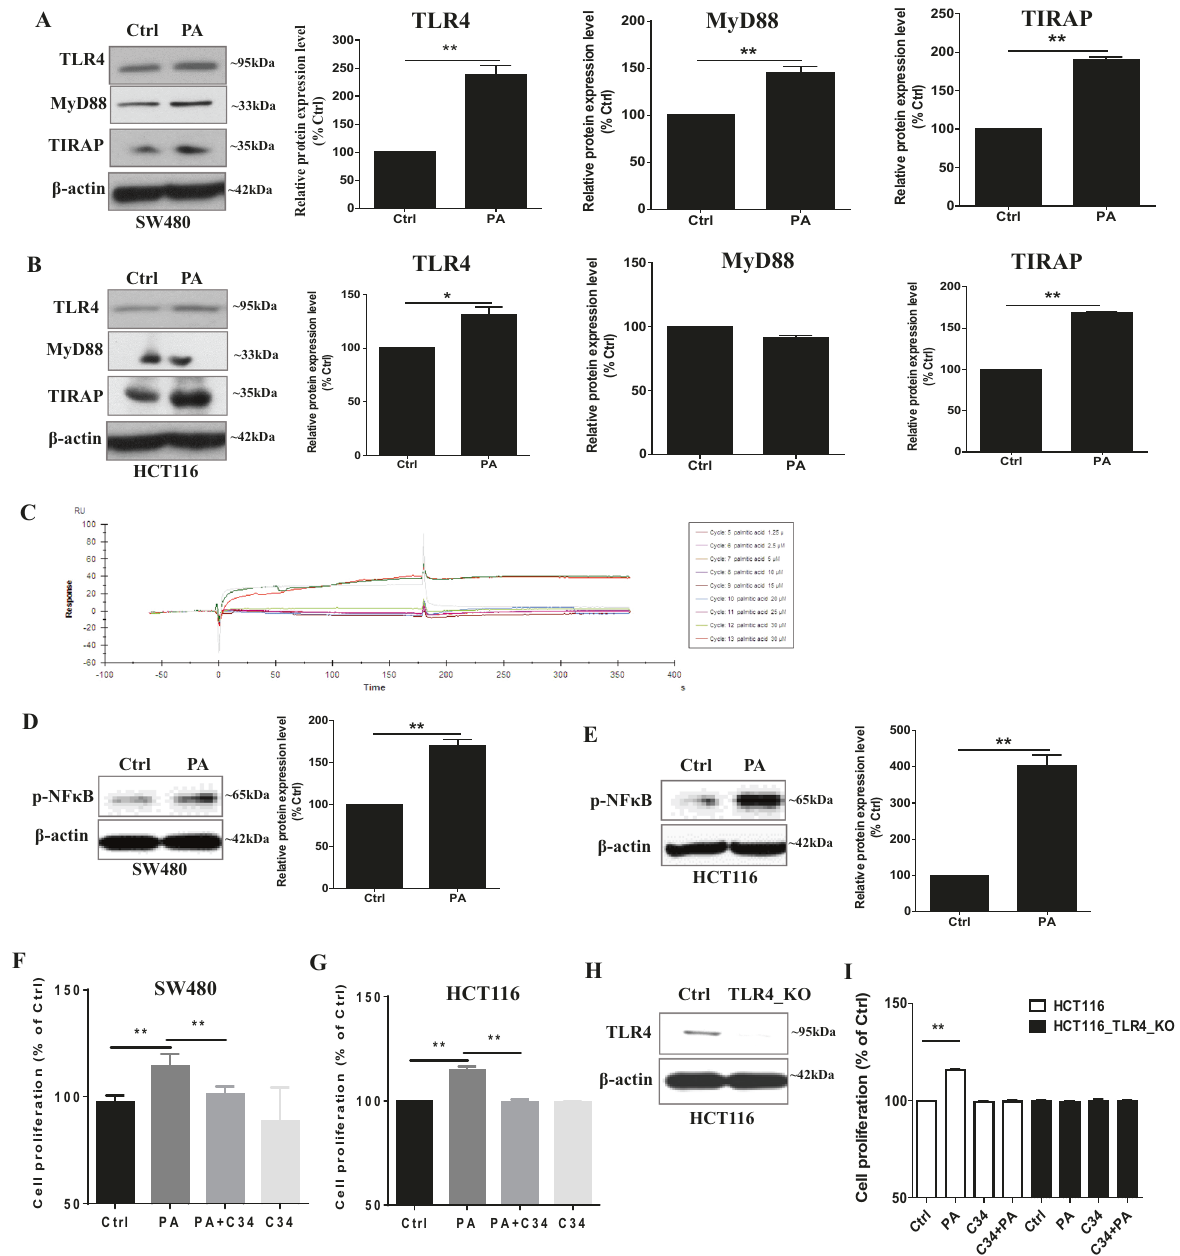
Fig. 4 Palmitic acid increases CRC cell proliferation in a TLR4-dependent manner. Protein expression of TLR4, MyD88, and TIRAP in A SW480 and B HCT116 cells after palmitic acid (PA, 50 µM) treatments. C Kinetics analysis of palmitic acid binding to TLR4 protein based on SPR platform Biacore X100. Representative sensorgrams were obtained from injections of palmitic acid at different concentrations as indicated. Expression of p-NF κ B in D SW480 and E HCT116 cells after palmitic acid (PA, 50 µM) treatments. Proliferation of F SW480 and G HCT116 cells after palmitic acid (PA, 50 µM) treatments in the presence or absence of C34. H Knockout of TLR4 in HCT116 cells (HCT116 TLR4- KO ). I Proliferation of HCT116 cells and HCT116 TLR4-KO cells after palmitic acid (PA, 50 µM) treatments in the presence or absence of C34. Data are shown as means ± SEM. n = 3 independent experiments. * p < 0.05, ** p < 0.01 as indicated. Fatty acid treatments were done in the presence of 1% fatty acid-free BSA, 1% fatty acid-free BSA alone served as control (Ctrl). Studies show that palmitic acid is a ligand for TLR4 [5, 6]. reported in which TLR4 siRNA inhibits proliferation and invasion of However, a recent study using molecular dynamics simulations CRC by downregulating acyl coenzyme A cholesterol acyltransfer- demonstrates that the presence of palmitate molecules within the ase 1 (ACAT1) [36]. ACAT1 is an intracellular enzyme that catalyzes active TRL4/MD2 receptor complex will destabilize the complex the formation of cholesterol ester from free cholesterol and long- [26]. Furthermore, palmitic acid does not induce TLR4 dimerization chain fatty acids. Besides, TLR4 also increases GSK3 β phosphor- or endocytosis [26]. Our data on the surface plasmon resonance ylation and the related lipogenic enzymes hence increase the (SPR) suggest that palmitic acid is less likely binding onto TLR4 metastatic ability of CRC [37]. Cell Death and Disease (2021)